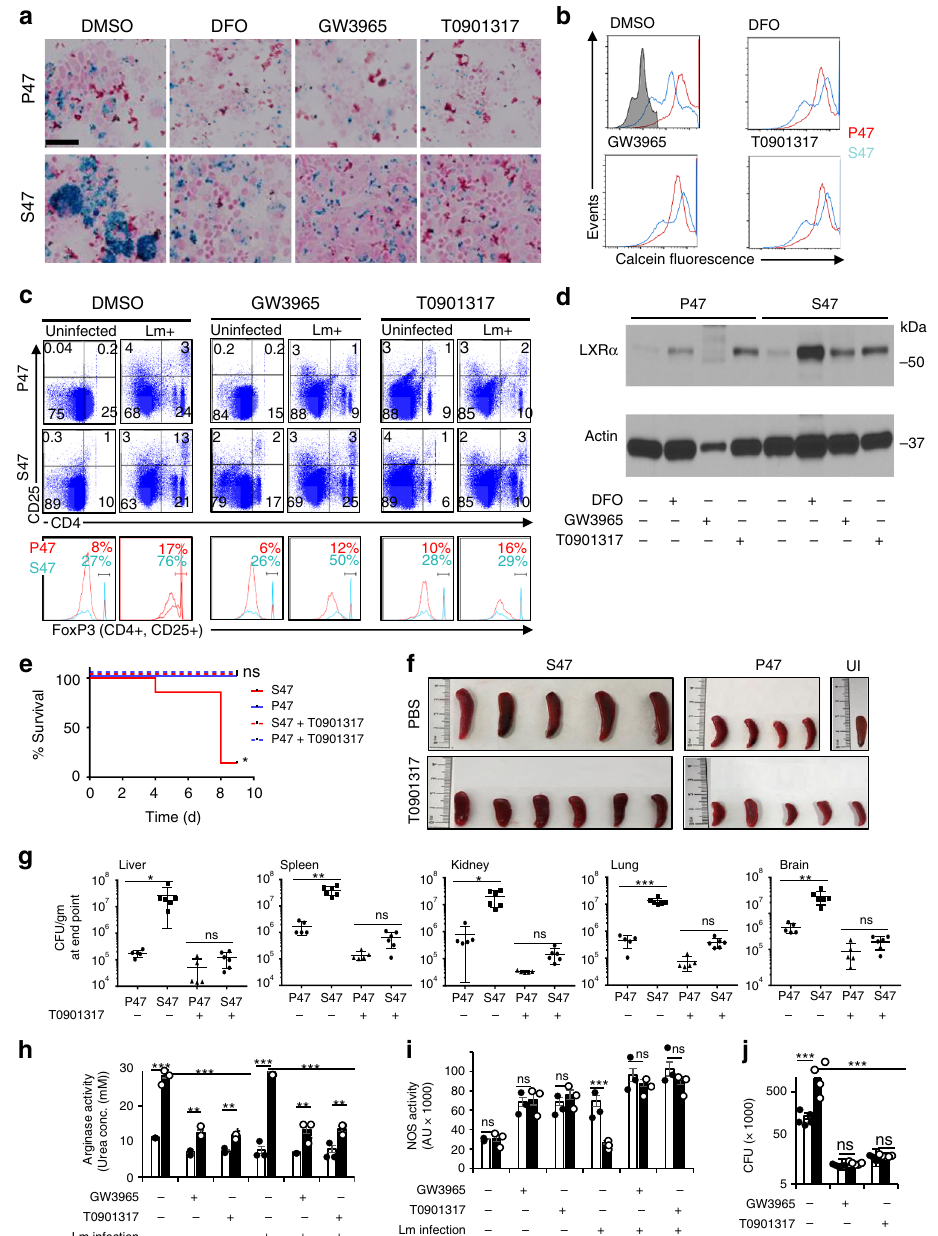
Fig. 6 LXR agonists lower iron content, reverse anti-in fl ammatory response, and improve Lm killing in S47 mouse macrophages. a Iron accumulation in P47 and S47 MDMs under different treatment conditions by Prussian blue staining. ( n = 10 biological replicates, 3 – 4 fi elds per sample), Bars, 50 μ m. b Iron levels in P47 and S47 MDMs under different treatment conditions measured by loss of calcein fl uorescence. Gray histogram = unstained control. (representative from 10 biological replicates). c P47 and S47 mouse splenocytes pretreated with DMSO, GW3965, or T0901317 analyzed for CD4 + , CD25 + and FoxP3-Hi Treg at baseline or in the presence of Lm infection. d Relative protein levels in P47 and S47 mouse MDMs measured by immunoblot after 24 h of indicated treatments. e S47 & P47 mice infected with Lm are treated with PBS or LXR agonist T0901317 and monitored daily from day 2 post infection for survival ( n = 5 – 6 biological replicates) f Spleens of P47 and S47 mice at 9 days post infection. scale = 4 cm. g Bacterial load in different